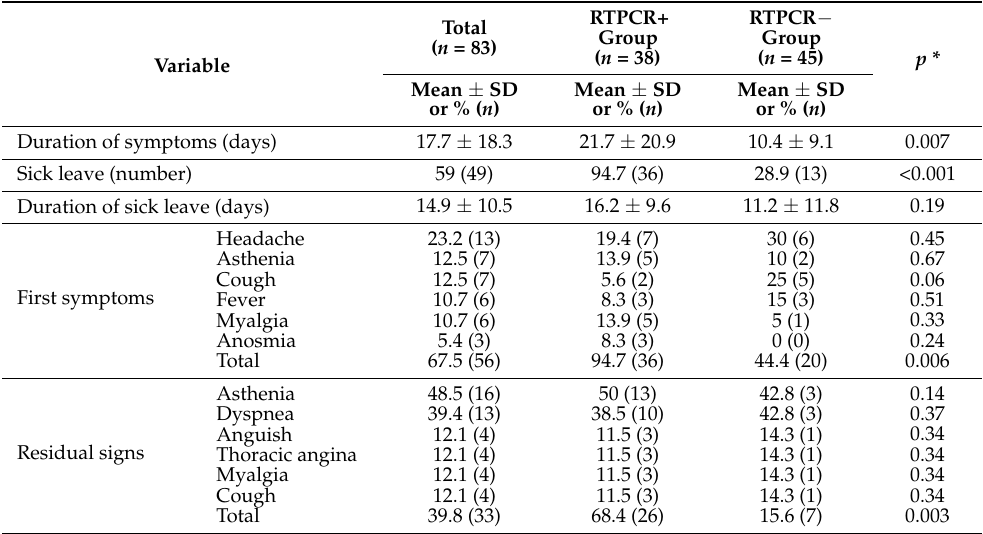
Table 4. Clinical characteristics of COVID-19 in participants and comparison between the RTPCR+ and RTPCR − groups.